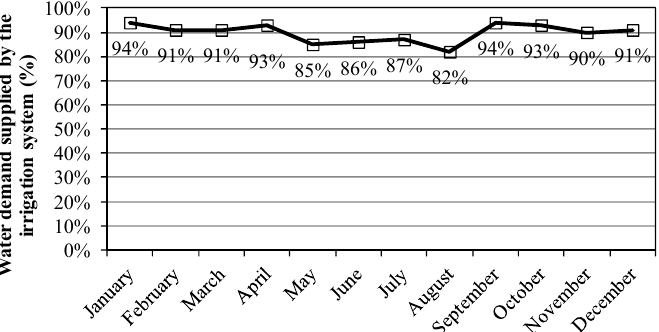
Figure 12. Percentage of the total demand supplied by the irrigation system.